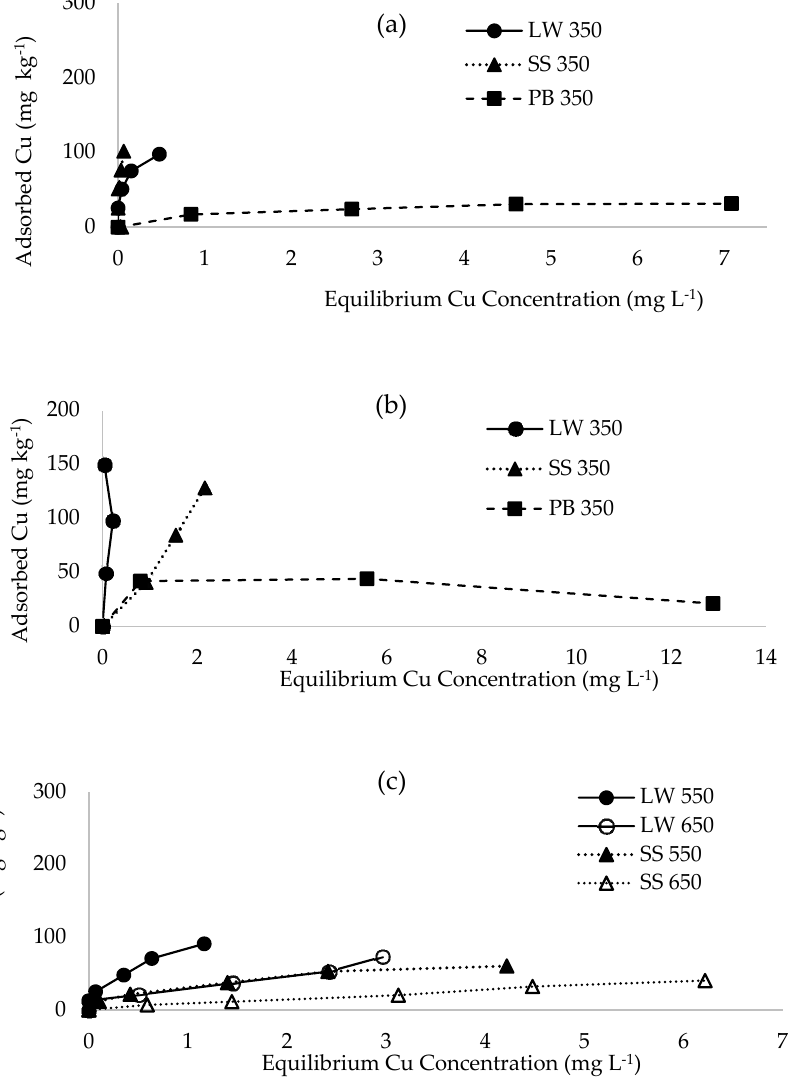
Figure 3. Sorption isotherms of copper from: ( a ) e ffl uent on biochar pyrolysed at 350 ◦ C, ( b ) single metal on biochar pyrolysed at 350 ◦ C and ( c ) e ffl uent on biochar pyrolysed at 550 and 650 ◦ C. LW = latrine waste biochar, SS = sewage sludge biochar, PB = pine-bark